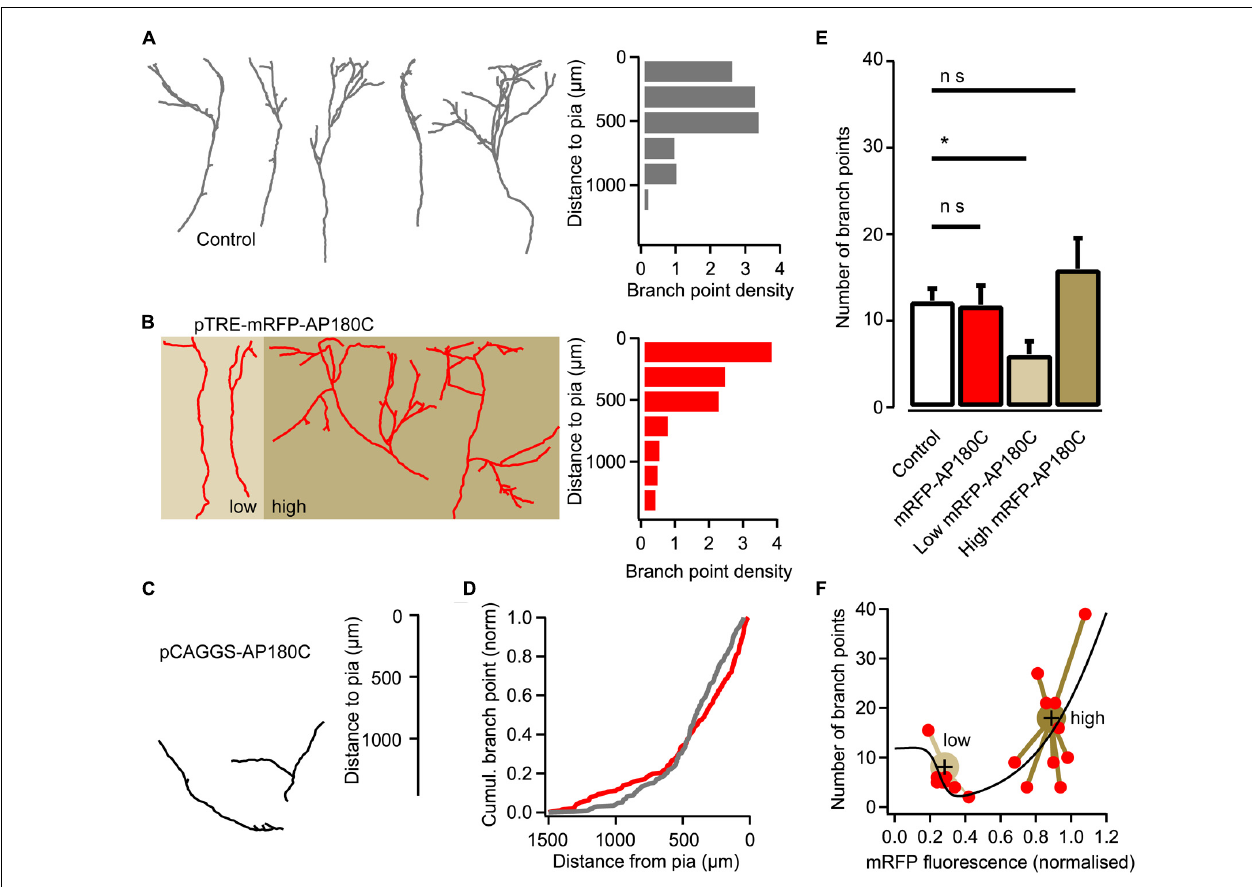
FIGURE 3 | Reducing clathrin-mediated endocytosis withAP180C affects axon branching . (A) Reconstructions of representative axons from thalamic cells in the neocortical explant and a histogram showing the distribution of axonal branch points with respect to the pial surface. Control axons exposed to doxycycline for two days. Branch-point density = number of branch points/number of axons. (B) Reconstructions of representative axons from thalamic cells where the expression of mRFP-AP180C was induced with doxycycline two days earlier. A histogram showing the distribution of axonal branch points with respect to the pial surface is shown on the right. Axons expressing low amount of mRFP-AP180C are against a light brown background. Axons expressing high amount of the construct are against a dark brown background. (C) Reconstructions of representative axons from thalamic cells expressing mRFP-AP180C for 13 days. (D) Cumulative plot of